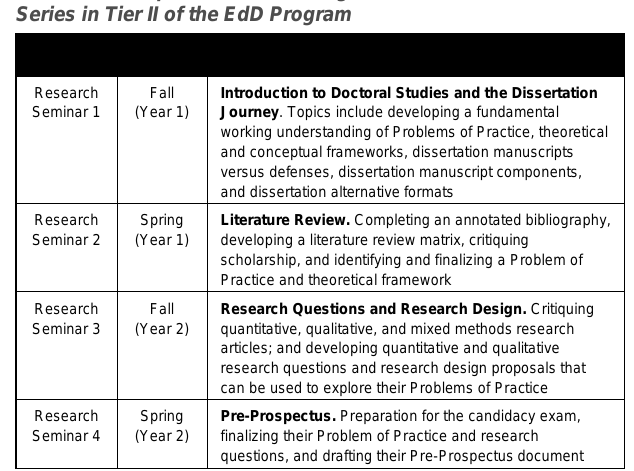
Table 2. Description of the Redesigned Research Seminar Series in Tier II of the EdD Program